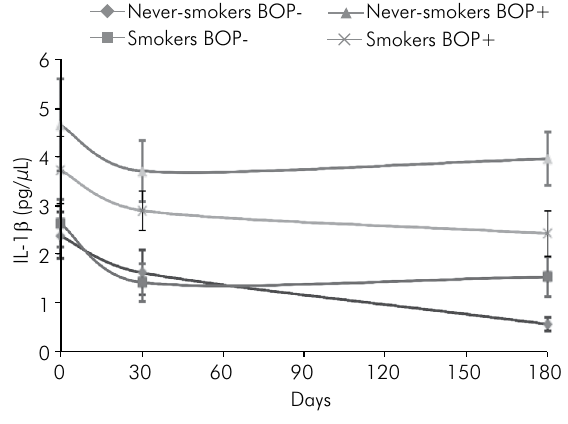
Figure 3. Means (with standard-error bars) of IL-1 β concentration over the study period by smoking status and BOP at 180 days.